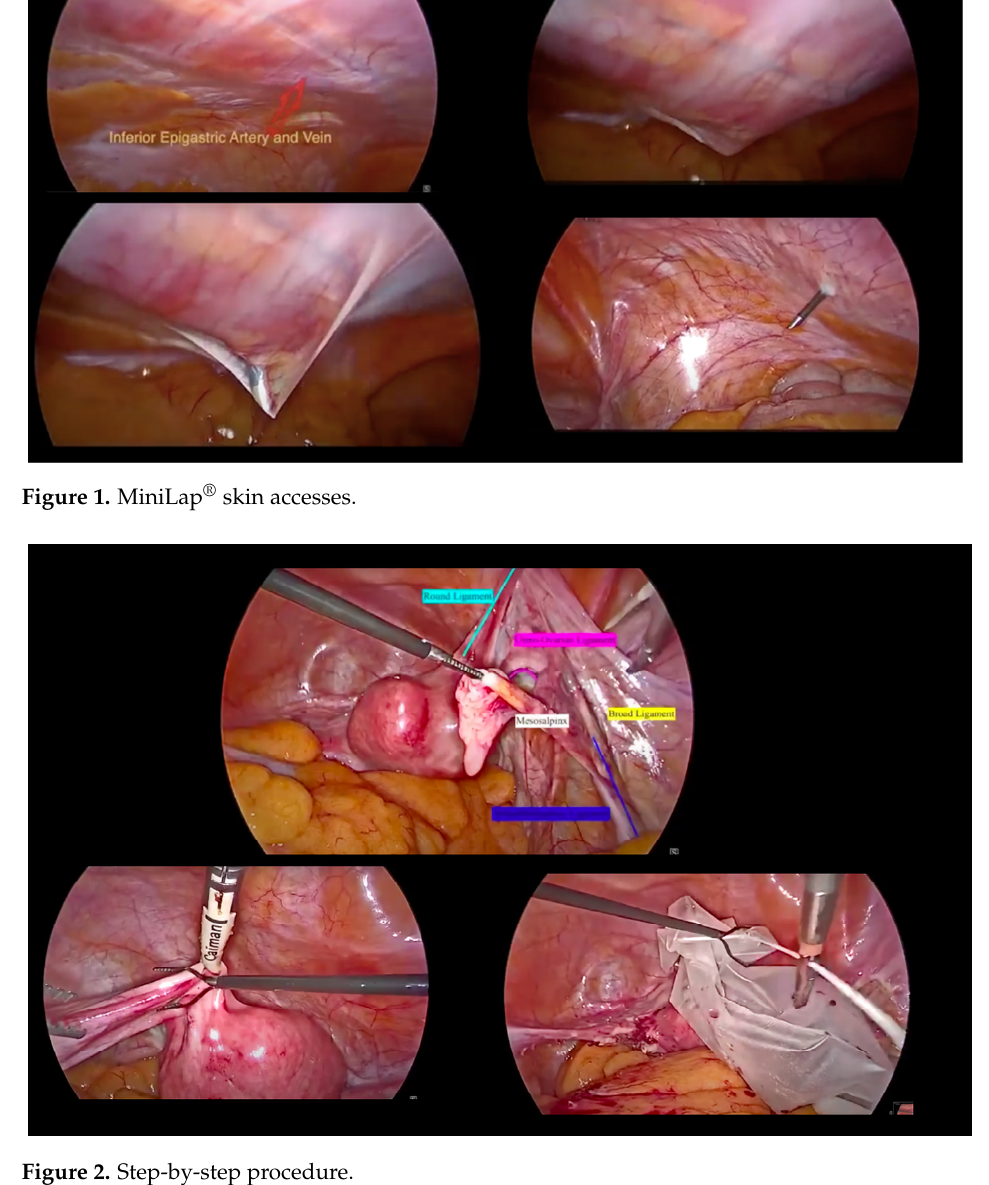
Figure 2. Step-by-step procedure.